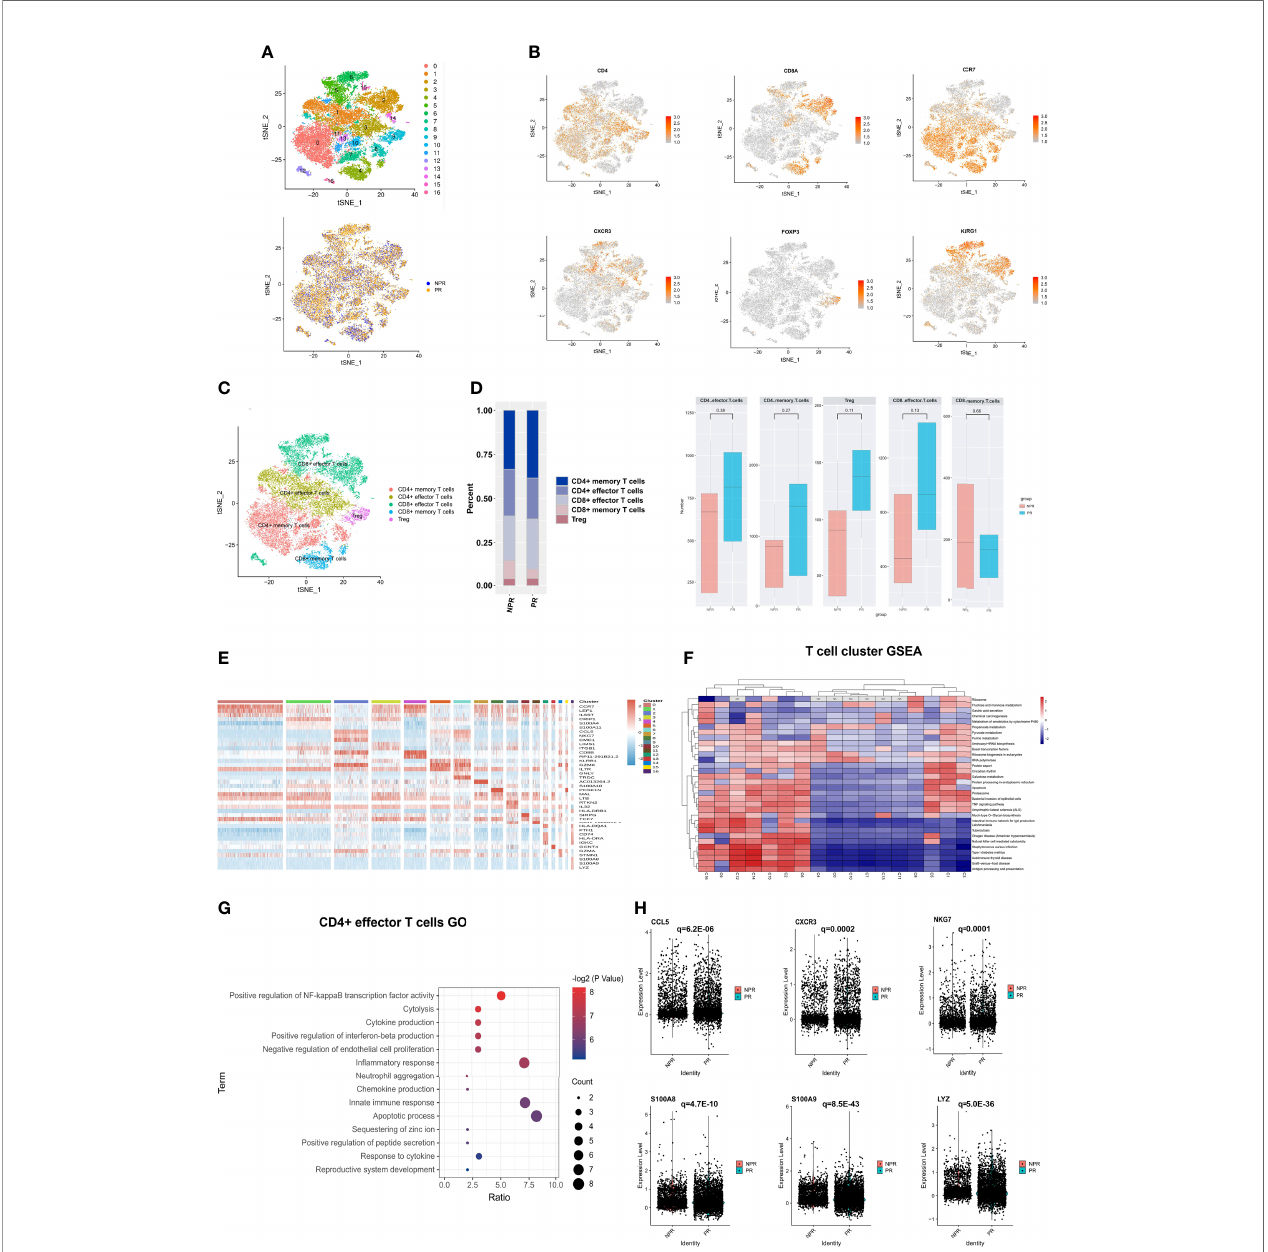
FIGURE 4 | Characterizations of T cells in patients with and without plaque rupture. (A) t-SNE plot showing re-clustering of T cells into 17 clusters and t-SNE plot of patients with PR and NPR. (B) Expression t-SNE plot of T cell marker genes as CD4, CD8A, CCR7, CXCR3, FOXP3 and KLRG1. (C) Percentage of T cell subtype in patients with PR and NPR. (D) t-SNE plot showing the contribution of different T cell subsets. (E) Heatmap showing expression levels of discriminative genes for each cluster. (F) GSEA heatmap of T cell clusters. (G) GO analysis of upregulated genes in CD4 + effector T cells from patients with PR. (H) Expression of pro- in fl ammatory hub genes such as CCL5, CXCR3, NKG7, S100A8, S100A9, and LYZ were signi fi cantly upregulated in CD4 + effector T cells of patients with